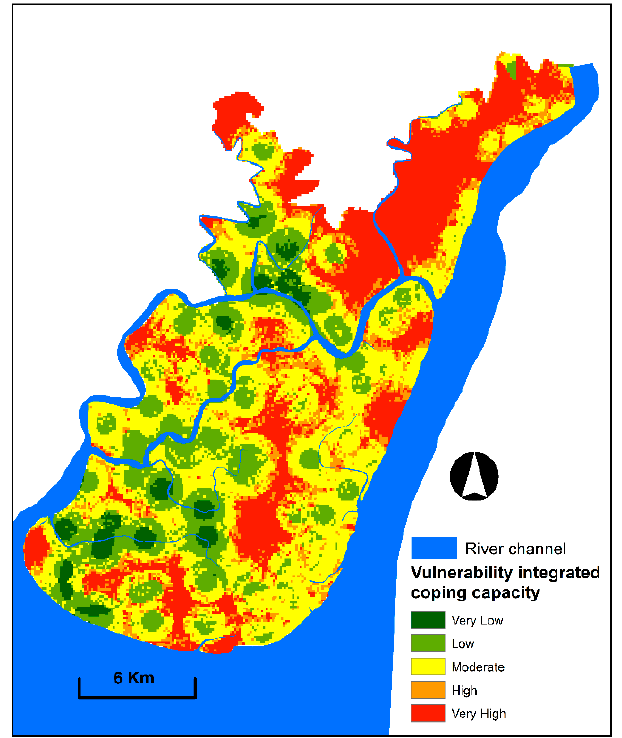
Figure 10. Vulnerability integrated coping capacity map exhibiting spatial patterns and the degree of vulnerability to floods.